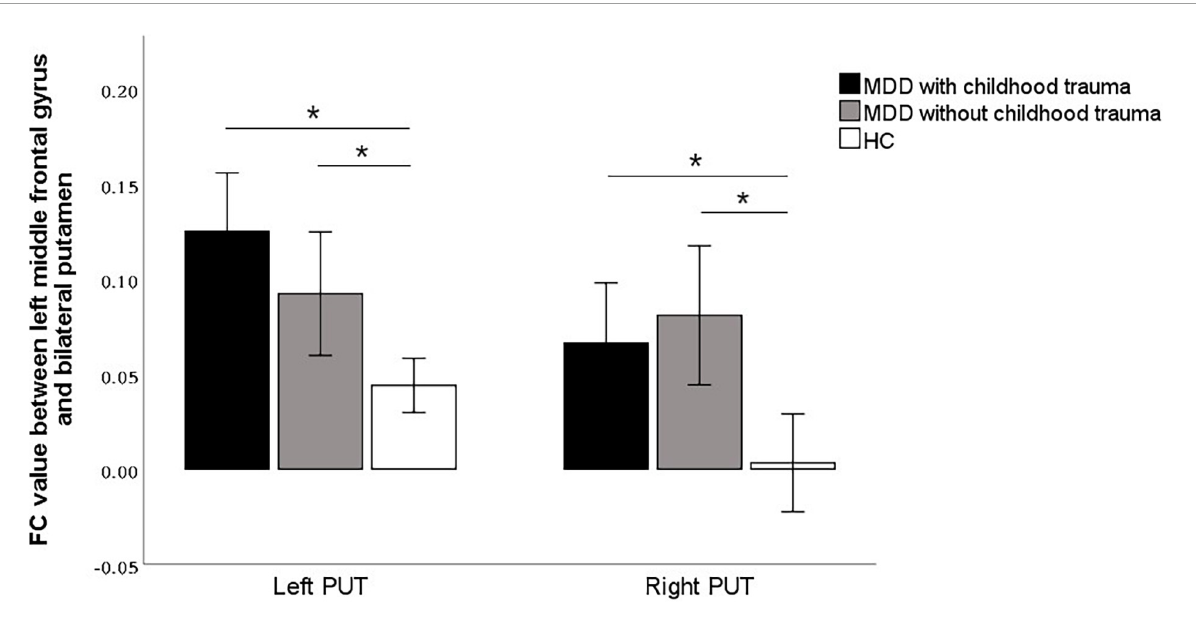
FIGURE4 Post hoc analyses revealed significant increased functional connectivity of left PUT to left middle frontal gyrus in MDD with childhood trauma compared to both MDD without childhood trauma and HC group. The functional connectivity of right PUT to left middle frontal gyrus in the MMD patient groups were significantly higher than that in the HC group, but there was no significant difference between those with and without childhood trauma. *Bonferroni correction with P < 0.025 was set for significance.